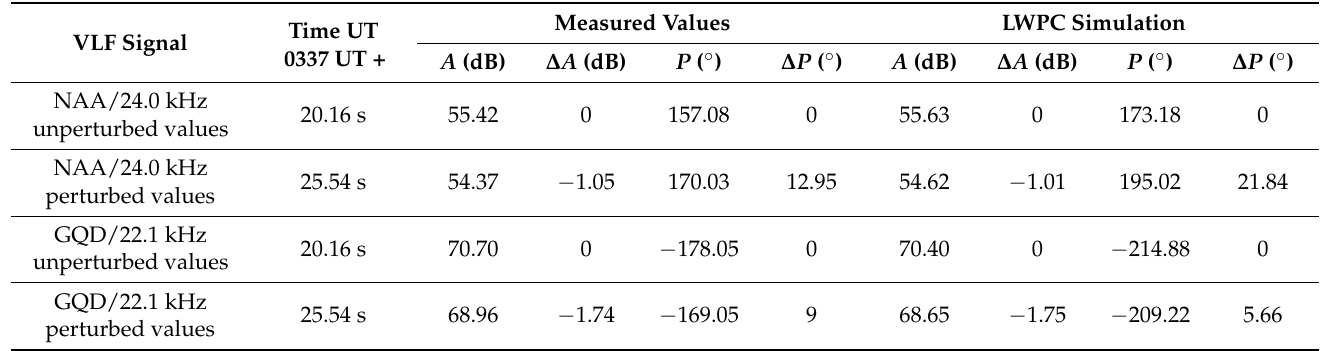
the Belgrade receiver site (Table 1: first and third rows indicate unperturbed VLF signal values, while the second and fourth rows indicate the perturbed ones). Table 1. Measured and estimated amplitude and phase delay values of NAA and GQD signals during the LEP event that occurred on 16 November